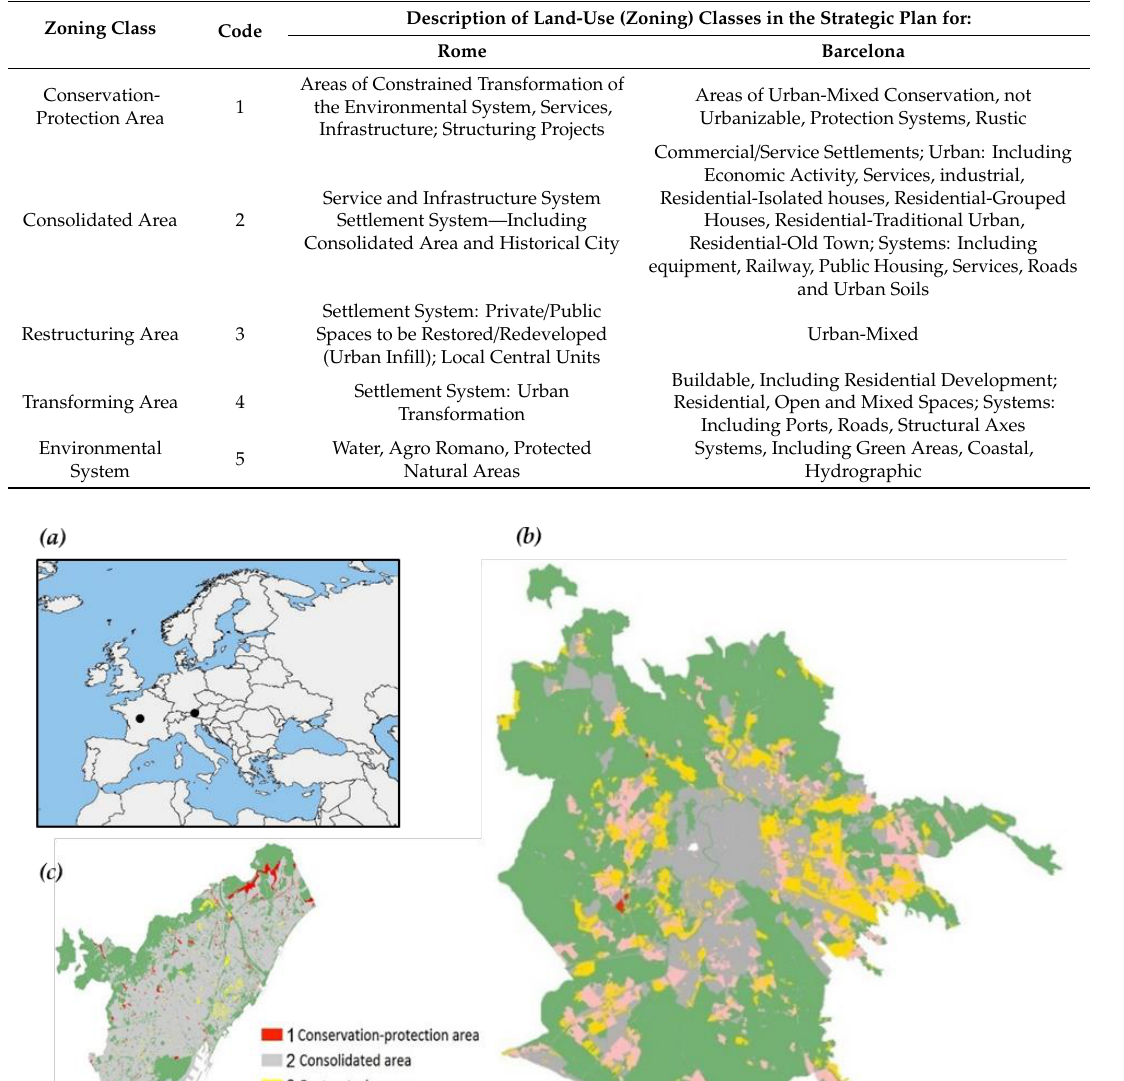
Table 1. Land use nomenclature system (zoning classes 1–5) adopted in the present study.